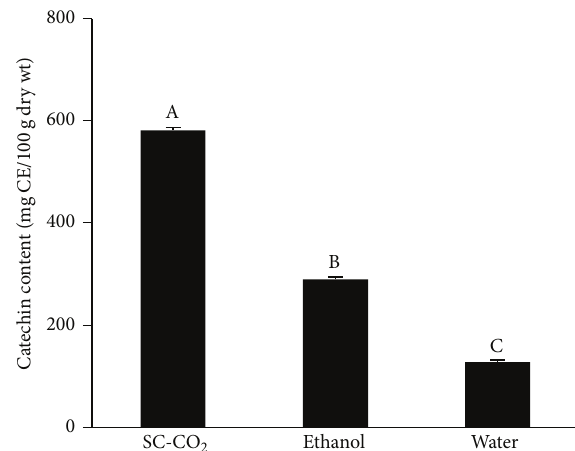
Figure 4: Effects of SC-CO 2 extraction on catechin content of Antidesma thwaitesianum . Values are mean ± SD ( 𝑛 = 3 ). CE, cate- chin equivalent. Means with different letters (A–C) are significantly different ( 𝑃 < 0.05